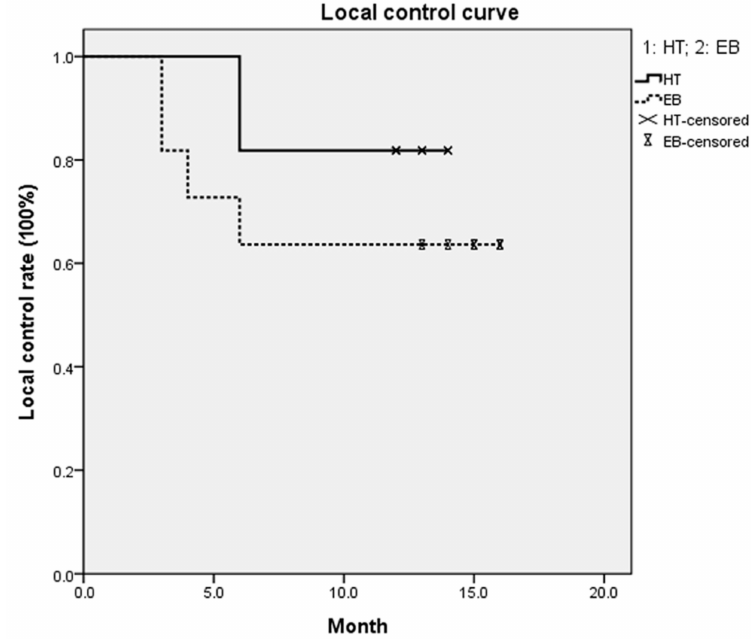
Figure 4. One-year local control rates for patients treated with helical tomotherapy or electron beam irradiation. There were no significant di ff erences between the HT and electron beam (EB) groups ( p = 0.238).